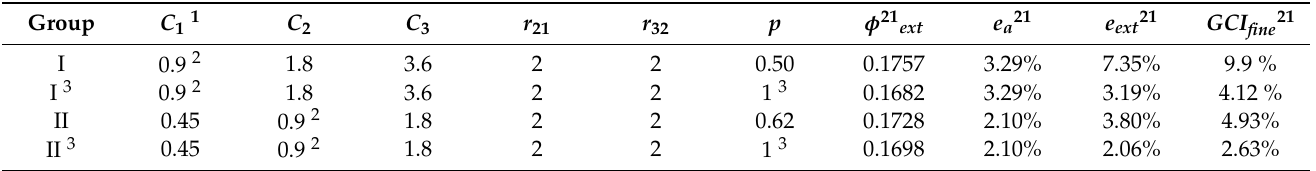
Table A3. Sample uncertainty analysis by different temporal